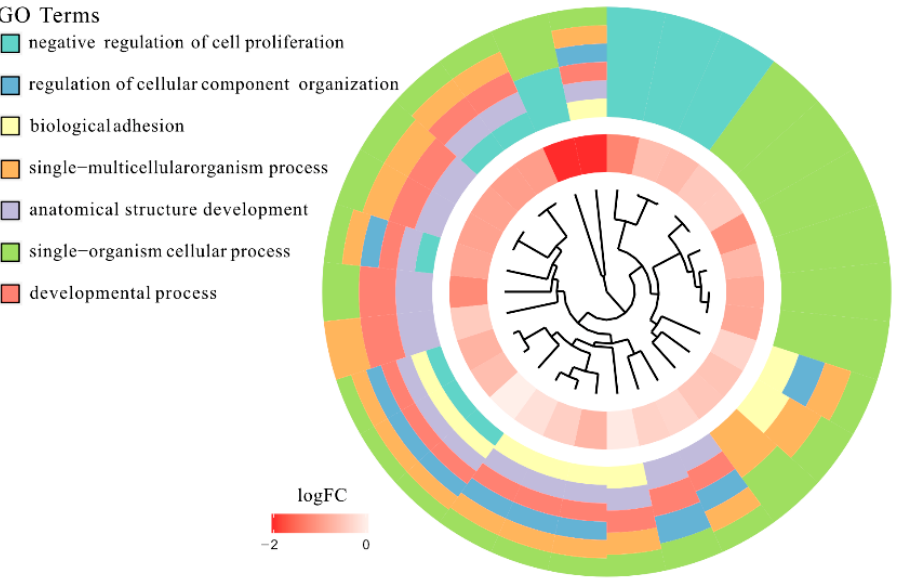
Figure 4. The representation of hierarchical clusterization, fold change, and assignment of differently expressed genes that belongs to chosen anatomical structure development , biological adhesion , developmental process , negative regulation of cell proliferation , regulation of cellular component organization , single − multicellular organism process, and single − organism cellular process GO BP terms. Genes are grouped together based on their expression patterns, and the clusterization pattern is represented by dendrogram inside the circle. The middle ring represents the logarithm of gene expression fold change of studied genes between 15 and 7 days of culture, respectively. The outer ring represents the terms assigned to the genes.